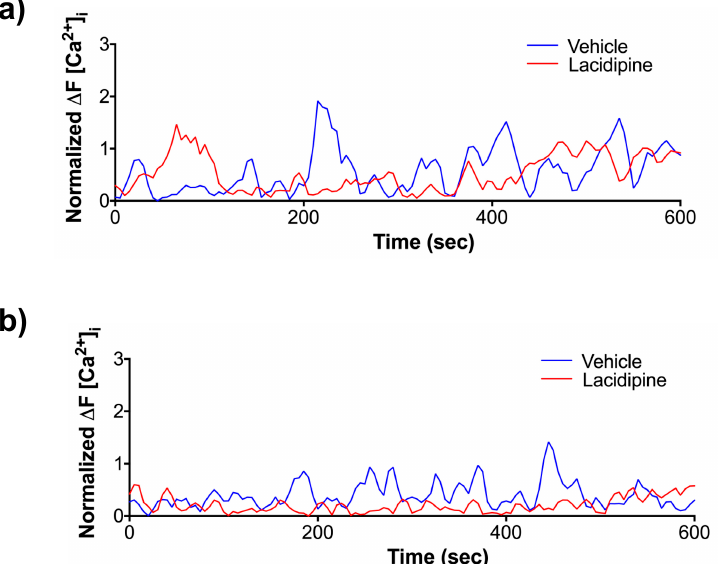
Figure 5. Ca 2+ imaging to detect the endogenous intracellular changes of Ca 2+ at early and late stages of tube formation. To monitor the intracellular temporal Ca 2+ dynamics, HUVEC were stably infected with genetically encoded Ca 2+ FRET sensor (GCaMP) using a lentiviral vector. Cells were time-lapse imaged using the high-content imaging system (Operetta) with 20 × objective at 5 s intervals for 10 min. The fluorescent signal was quantified using Harmony imaging software. For each individually tracked cell, a spherical region of interest to avoid overlapping with adjacent cells. The mean fluorescent intensity of all cells at every time point was normalized to the baseline fluorescent intensity of GCaMP6. The graph traces are representative of three independent experiments. A total of 25–40 cells were included in the quantification for each experiment. ( a ) Representative traces illustrating a pattern of repeated i Ca 2+ spikes in HUVEC at an early stage (1 h) of the angiogenesis assay. ( b ) Representative traces showing that the generated i Ca 2+ spikes in the presence of Lacidipine (5 µ M) for 24